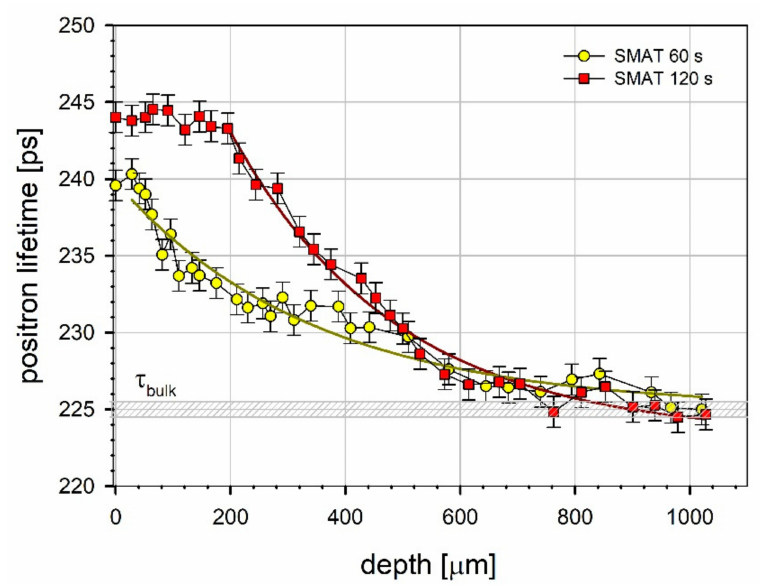
Figure 4. The mean positron lifetime profiles. The solid lines represent the best fit of the exponential decay function to the experimental points: τ bulk ( inps ) = 225 + 13.6exp [ − ( z − 28 ) /342.8 ] for the 60 s-SMATed sample and τ bulk = 223 + 20.2exp [ − ( z − 195 ) /285.7 ] for the 120 s-SMATed sample, where z is the depth from the treated surface in µ